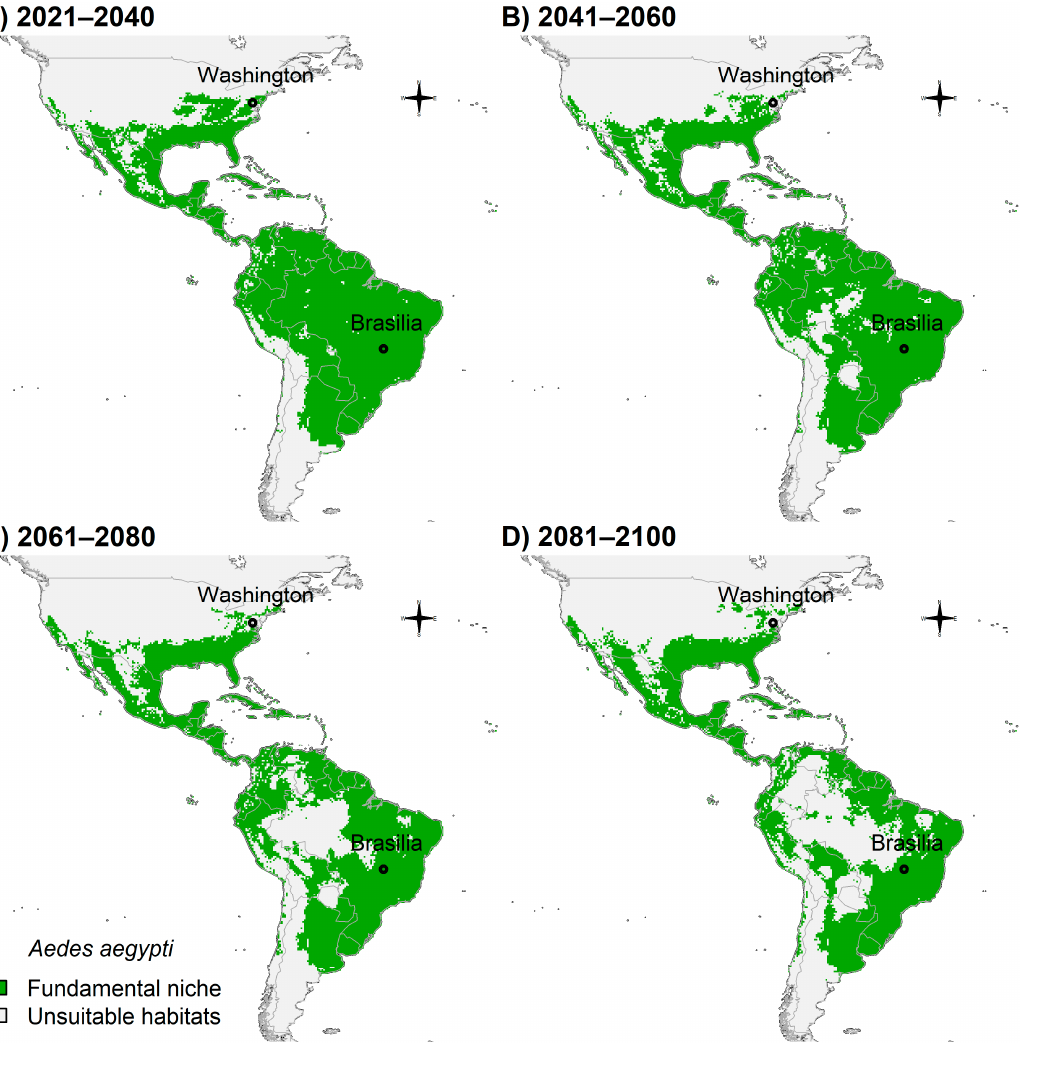
Figure 3. Potential future distribution of Ae . aegypti in Americas: ( A ) 2021–2040; ( B ) 2041–2060; ( C ) 2061–2080; and ( D ) 2081–2100. Future climate projections based on the global climate model GFDL- ESM4.1 by NOAA in the shared socio-economic pathway SSP3-7.0 of region rivalry. Locations of capitals of countries were shown for reference.